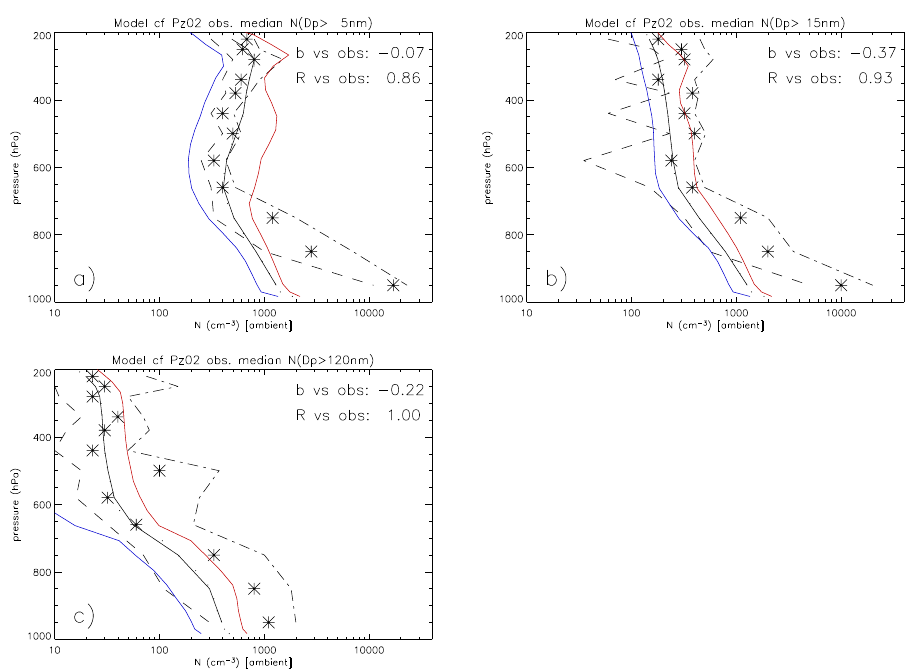
Fig. 23. Simulated vertical profiles of size-resolved number concentration compared to aircraft observations (Petzold et al., 2002) over NE Germany (13.5–14.5 ◦ E, 51.5–52.7 ◦ N) for particles larger than (a) 5nm, (b) 15nm, and (c) 120nm dry diameter ( D p ). Values of b and R are shown for each size-range from model values interpolated to a 1-km grid to match the observations. The black line shows simulated annual mean profile and the blue/red lines show minimum/maximum monthly-mean values. For the observations, the asterisks are median values whereas the dashed/dot-dashed lines are the 25th/75th percentiles as in Lauer et al